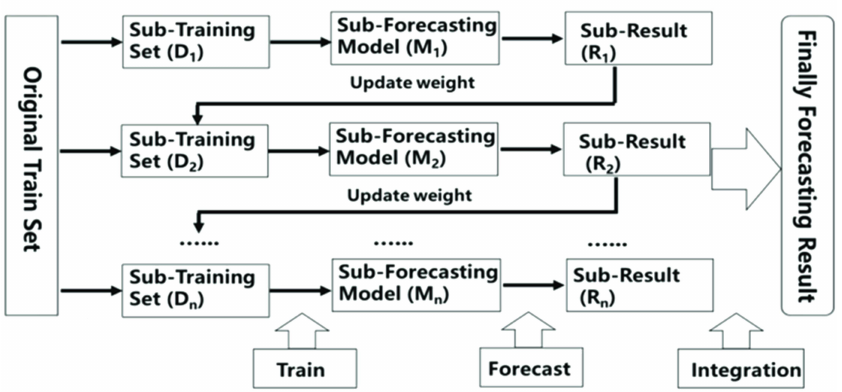
Figure 5. Illustration of Boosting Algorithm Architecture. “Adapted from [50]. (2021), Li, Y et al.”